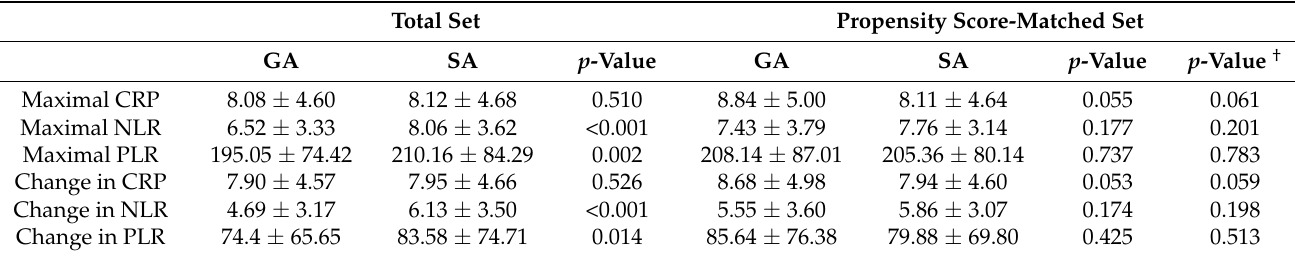
Table 3. Index representing systemic inflammatory response.